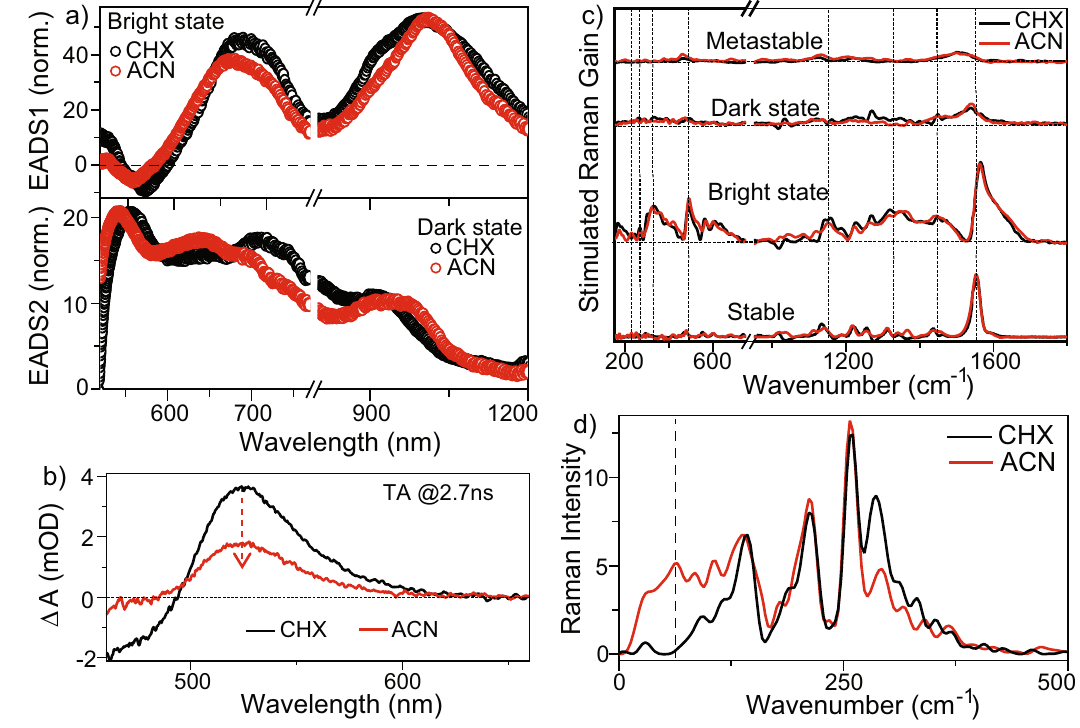
c femtosecond stimulated Raman spectra (bleach fi lled) of stable, metastable, bright and dark-states d impulsive Raman spectra obtained via Fourier transfor- mation of the oscillatory residual from time-resolved fl uorescence